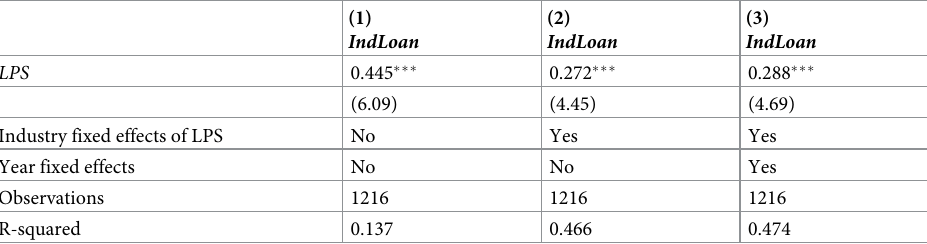
Table 2. The largest private shareholder and bank loans. This table reports the estimation results from OLS regres- sions analyzing the impact of the largest private shareholder on bank lending to their industry, with a different combi- nation of fixed effects in each column. Columns 1–3 uses IndLoan as the dependent variable. The results reporting the coefficients of the control variables are shown in S3 Appendix. Variables are defined in S1 Appendix. The sample period is from 2007 to 2020. In parentheses are t-statistics. ��� , �� , � indicate statistical significance at the 1%, 5%, and 10% level,